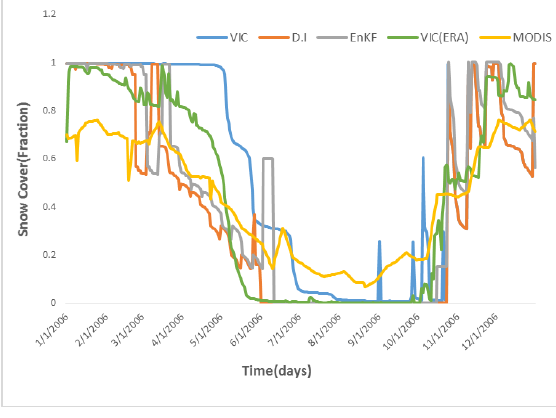
Figure 4.11 Snow Cover Comparison (2006)